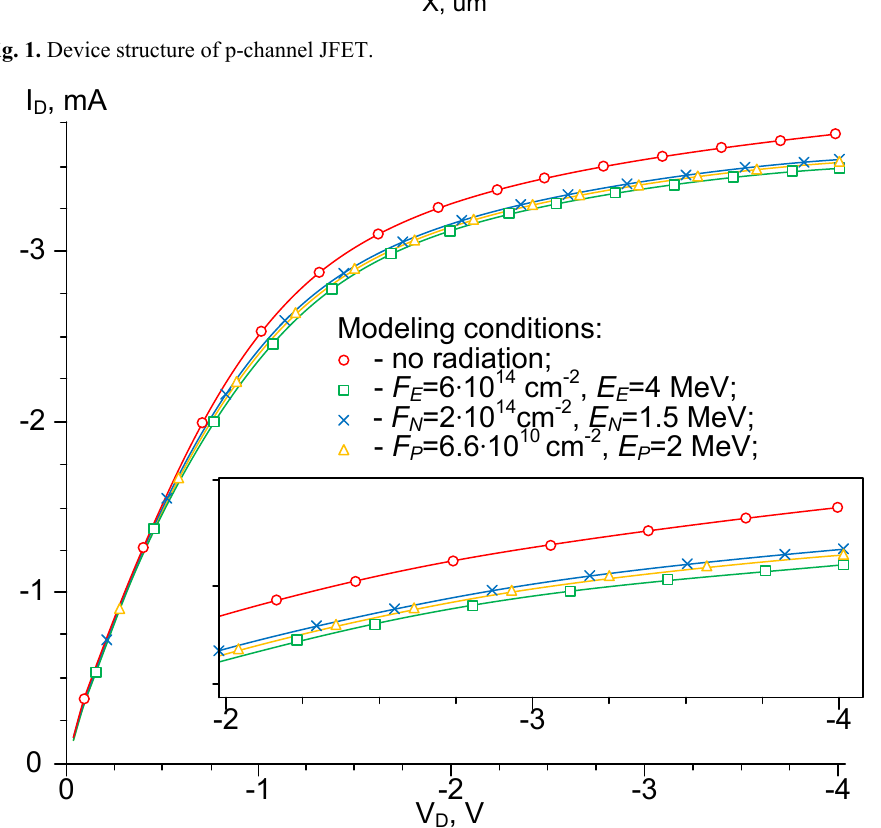
Fig. 2. Dependence of the drain current on the drain voltage VD when exposed to various types of penetrating radiations at a temperature 303